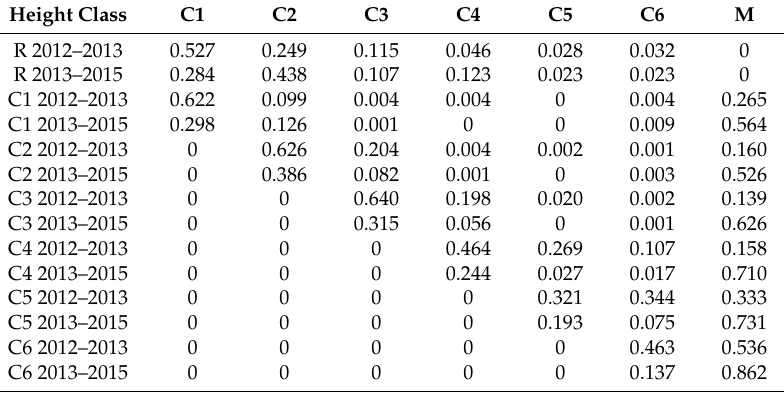
Table 4. Probabilistic transition of height (m) classes for Mora paraensis in Ajuruxi, south-eastern Amap á , Brazil, eastern Amazon, for the period 2012 to 2013 and 2013 to 2015. Where: R = Recruitment; M = Mortality; C1 (0.50–1.50 m); C2 (1.51–2.50 m); C3 (2.51–3.50 m); C4 (3.51–4.50 m); C5 (4.51–5.50 m); C6 (5.51–6.50